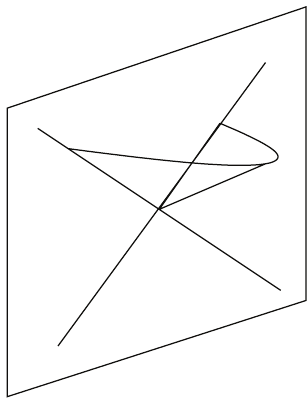
Figure 5: Single cusp